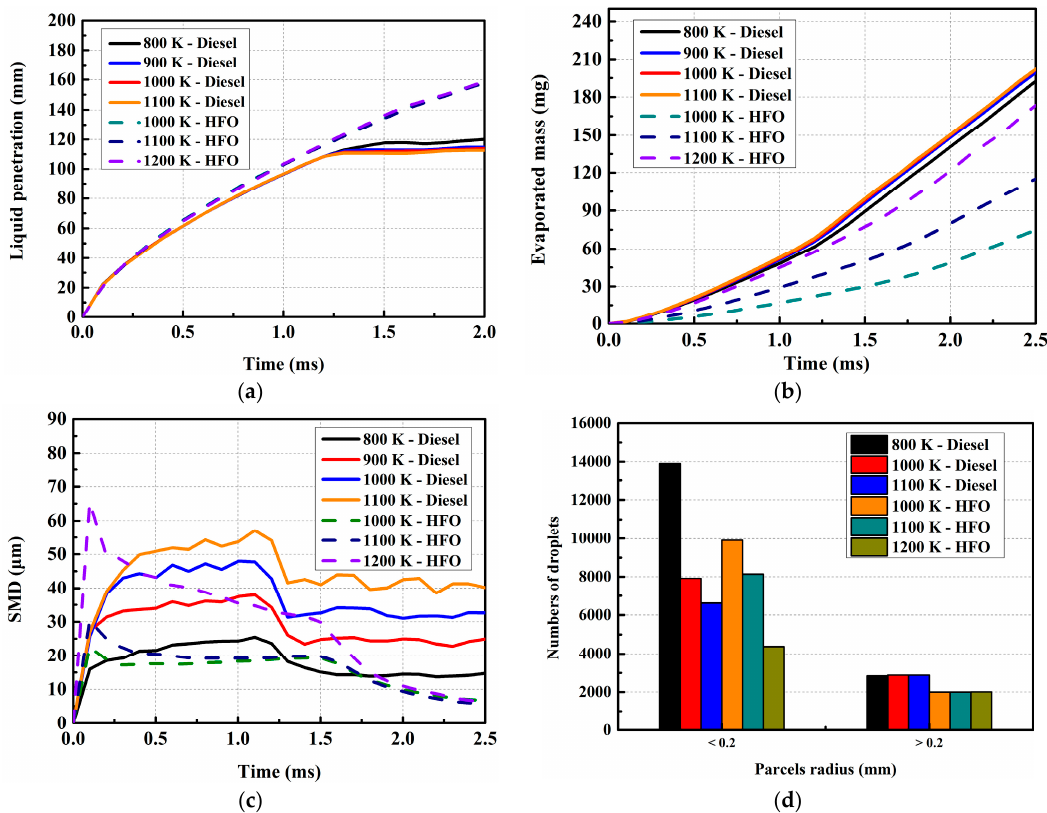
Figure 7. Comparison of diesel and HFO spray characteristics under different ambient temperatures. ( a ) Liquid penetration; ( b ) Evaporated mass; ( c ) SMD; ( d ) Parcel radius.